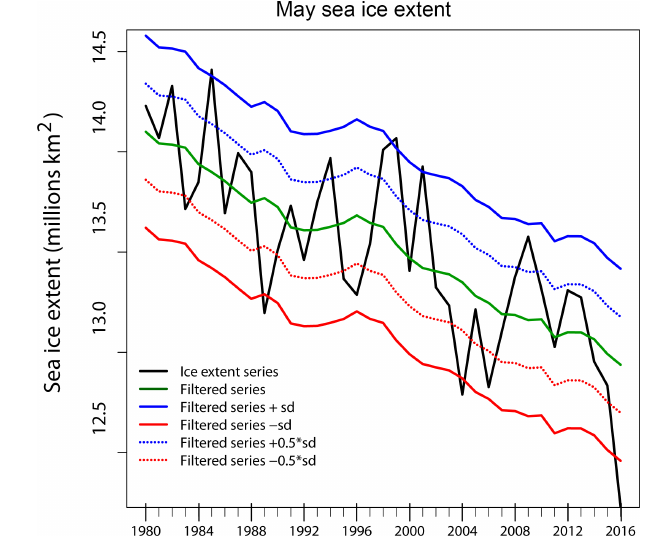
Figure 3. Monthly May Arctic ice extent series for the AR from 1980 to 2016 (black line), together with a filtered series using an 11-year running mean (green line). Blue (red) solid and dotted lines were obtained adding (subtracting) the standard deviations and half the standard deviation of the non-filtered series, respectively, to each of the values of the filtered